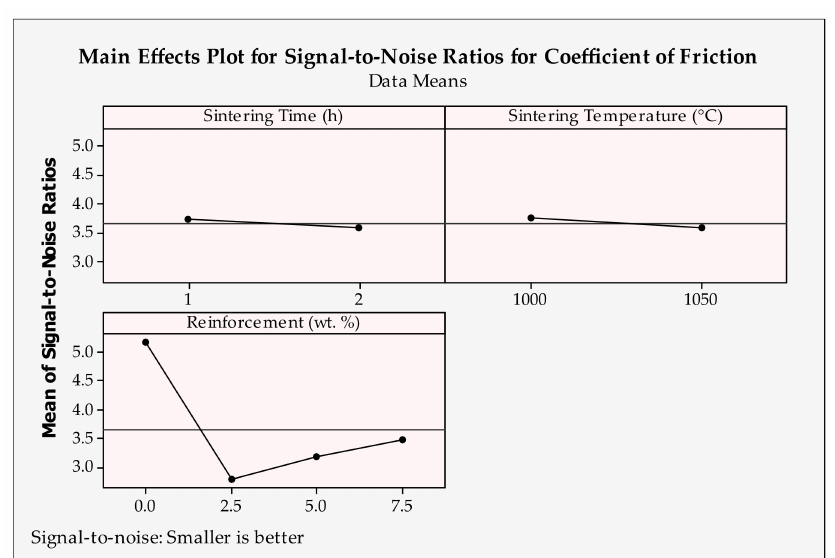
Figure 15. Signal-to-noise ratios of coefficient of friction for production